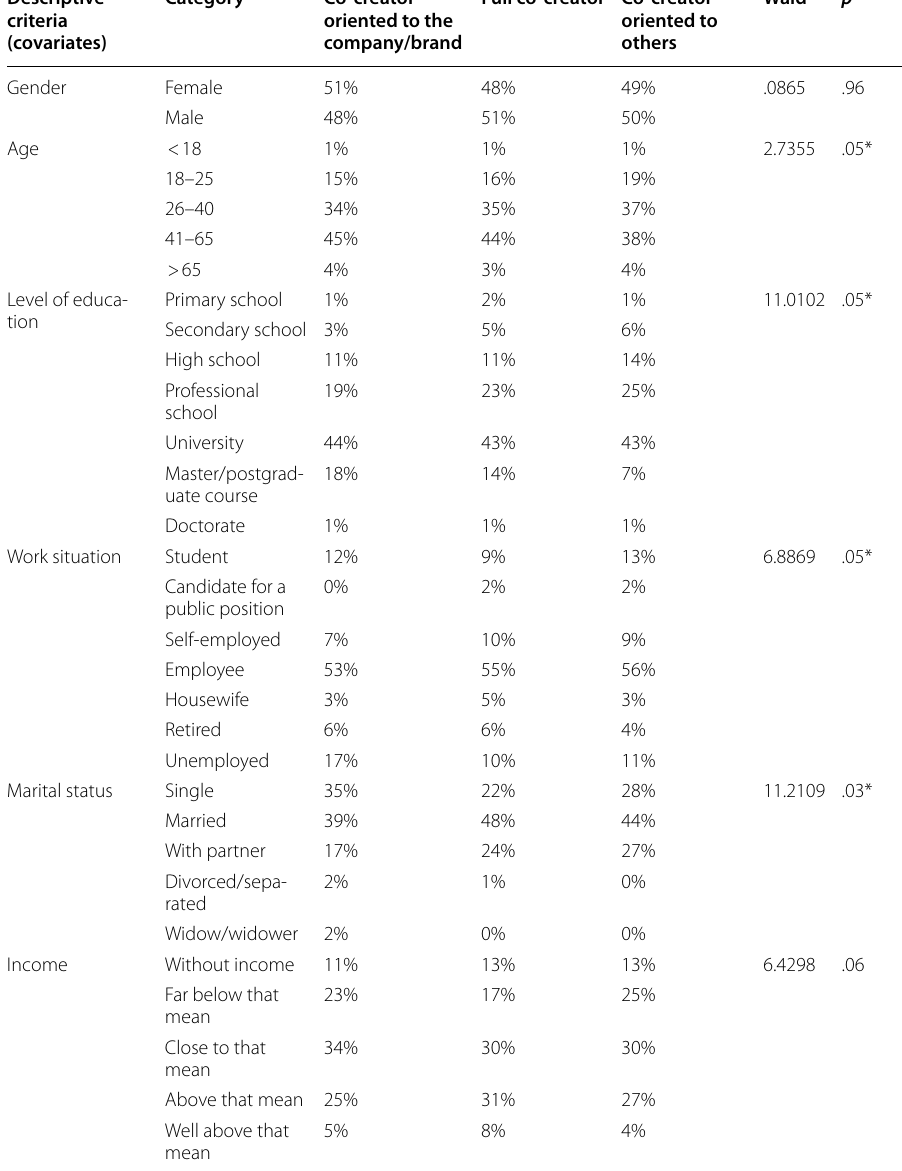
*Confidence level: 95%